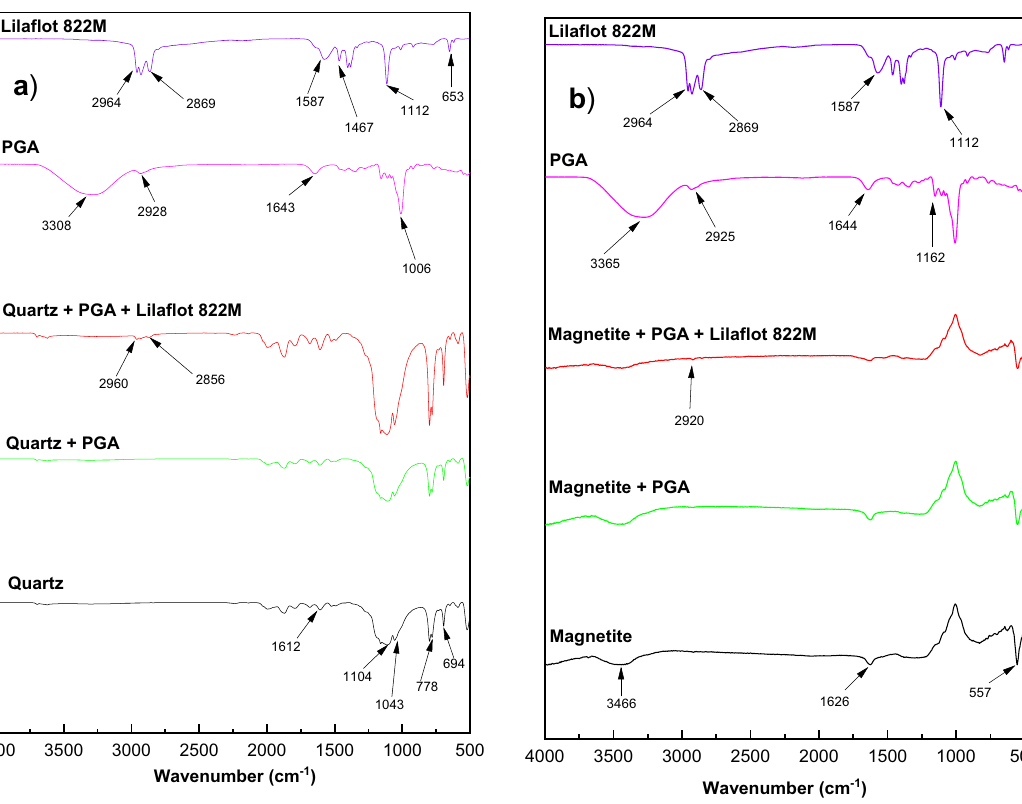
Figure 11. FTIR spectra of ( a ) quartz and ( b ) magnetite in the presence and absence of PGA and Lilaflot 822M (at 100